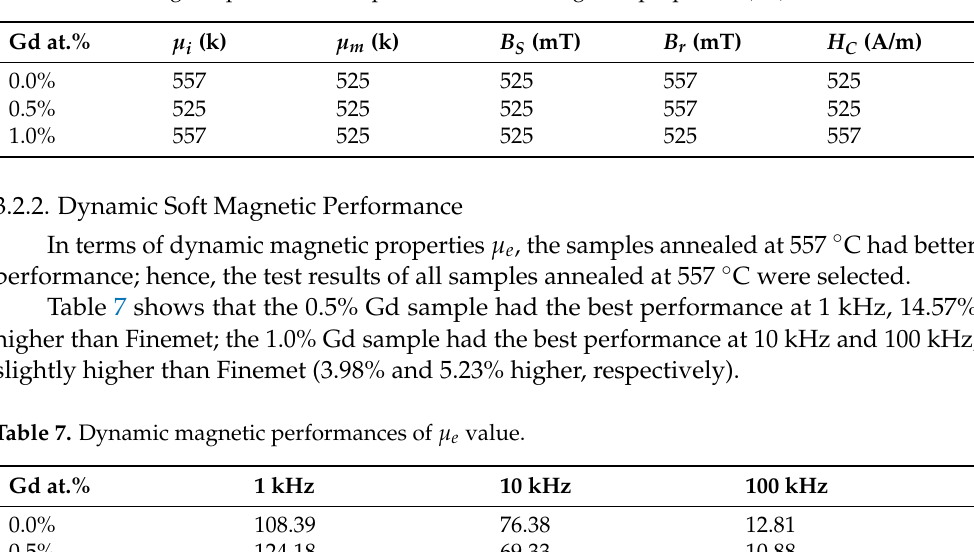
Table 6. Annealing temperatures for optimal static soft magnetic properties ( ◦ C).